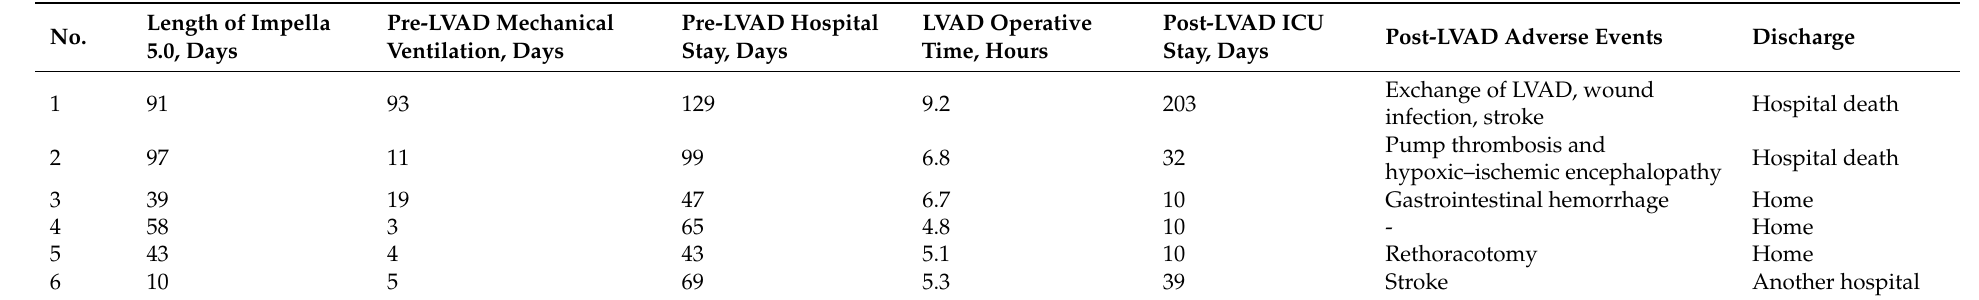
Table 2. Details of the treatment course, adverse events, and reasons for